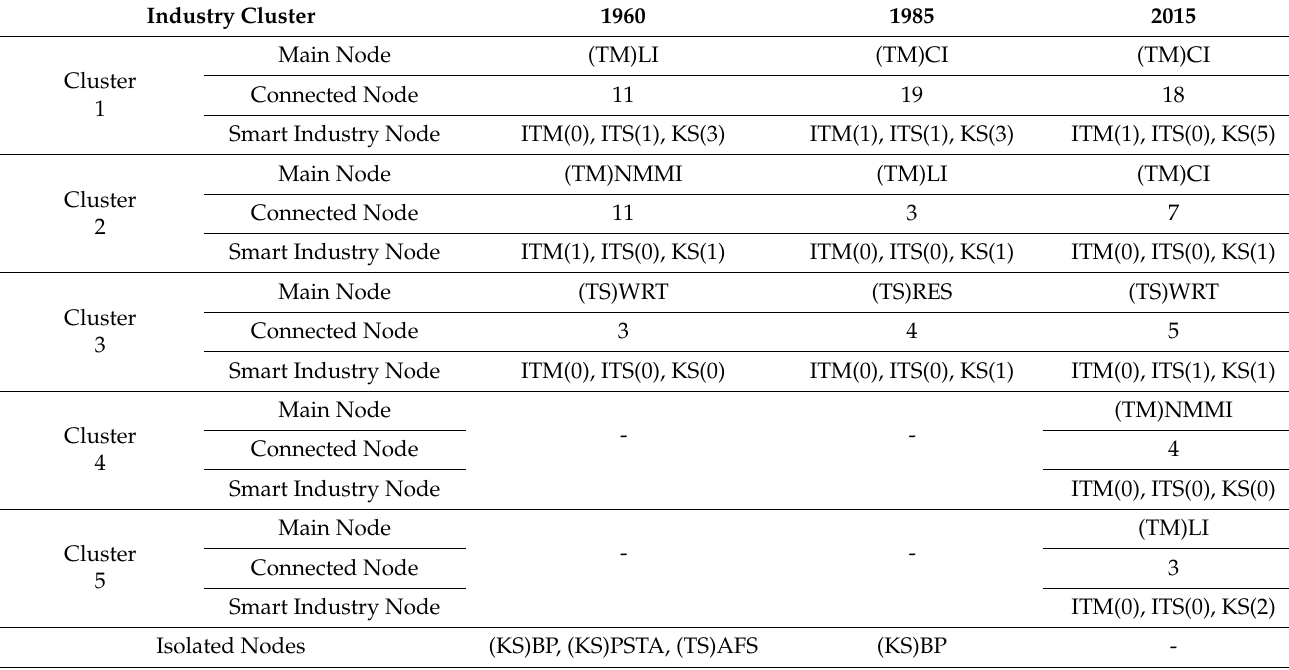
Table 5. Changes of smart network clustering (unit: